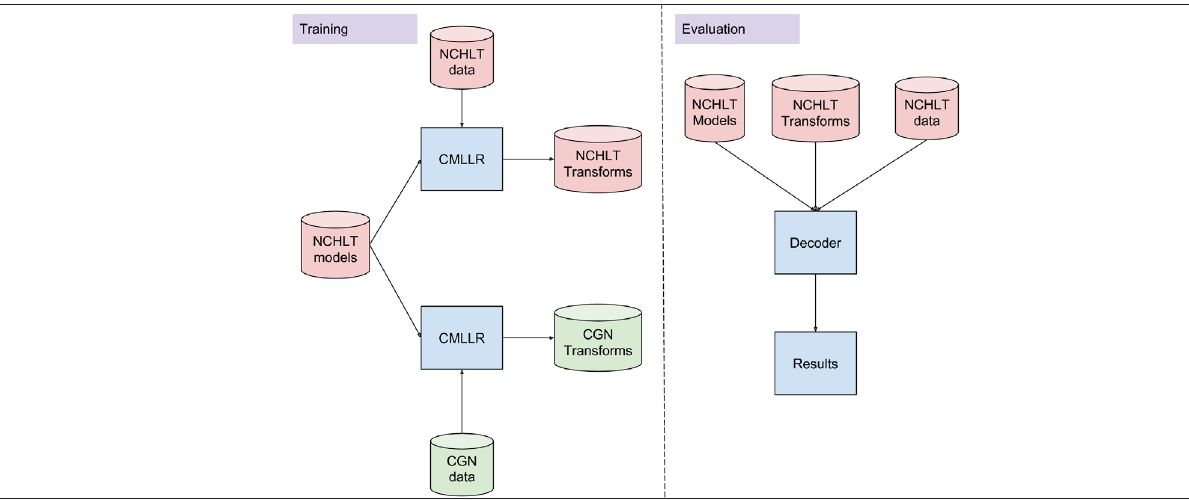
NCHLT, National Centre for Human Language Technology; CGN, Corpus Gesproken Nederlands Figure 2: Language constrained maximum likelihood linear regression (CMLLR) training